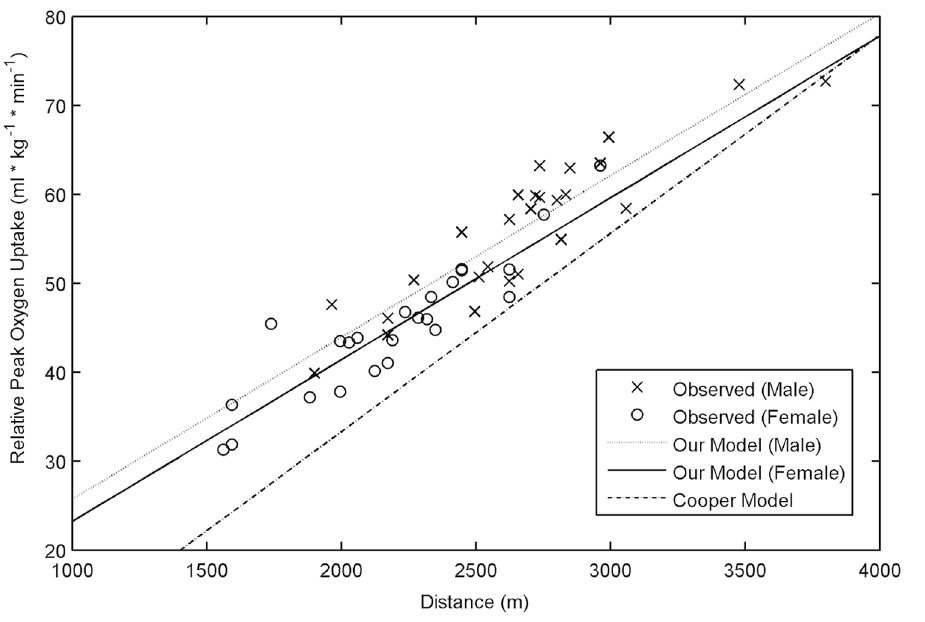
. Figure 1. Comparison of observed VO 2peak values to our model and the Cooper model. Our model was plotted for males and females. The . Cooper model underestimated observed VO 2peak in all but one male subject and demonstrated increased error with decreased 12-minute run/walk distance.